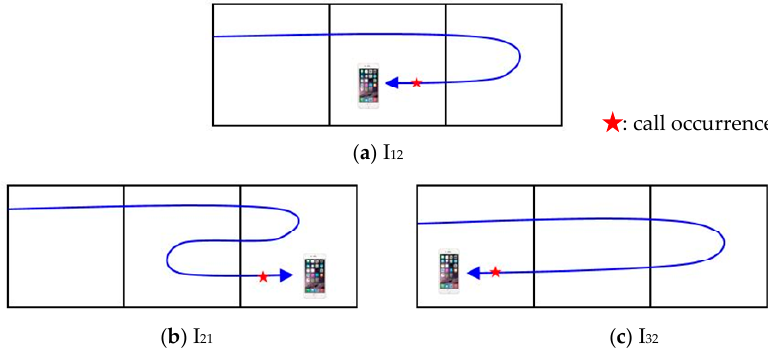
Figure 5. Examples of states I ij . : ( a ) I 12 ; ( b ) I 21 ; ( c ) I 32.